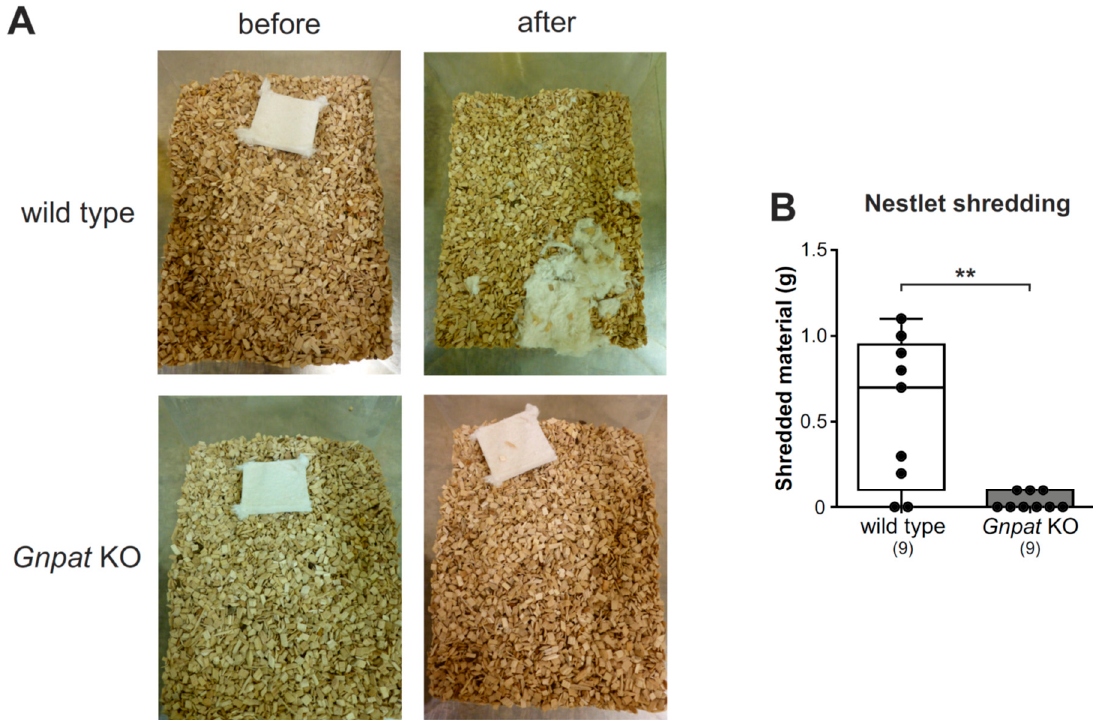
Figure 3. Reduced nestlet shredding in Gnpat KO mice: Nestlet shredding was evaluated in WT and Gnpat KO mice, and representative pictures are shown ( A ). The weight reduction of the nestlet after the trial was quantified, and the results are shown as box plots together with individual data points, and whiskers indicate minimal and maximal values ( B ). The number of tested animals is given in brackets. Statistical analysis was performed using the Mann–Whitney U test. ** p < 0.01 .